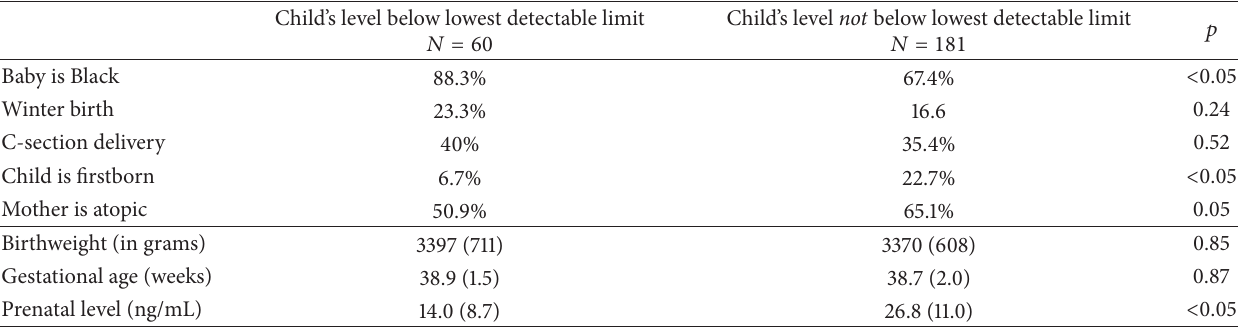
Table 4: Characteristics of children with 25(OH)D levels above and below the lowest detectable